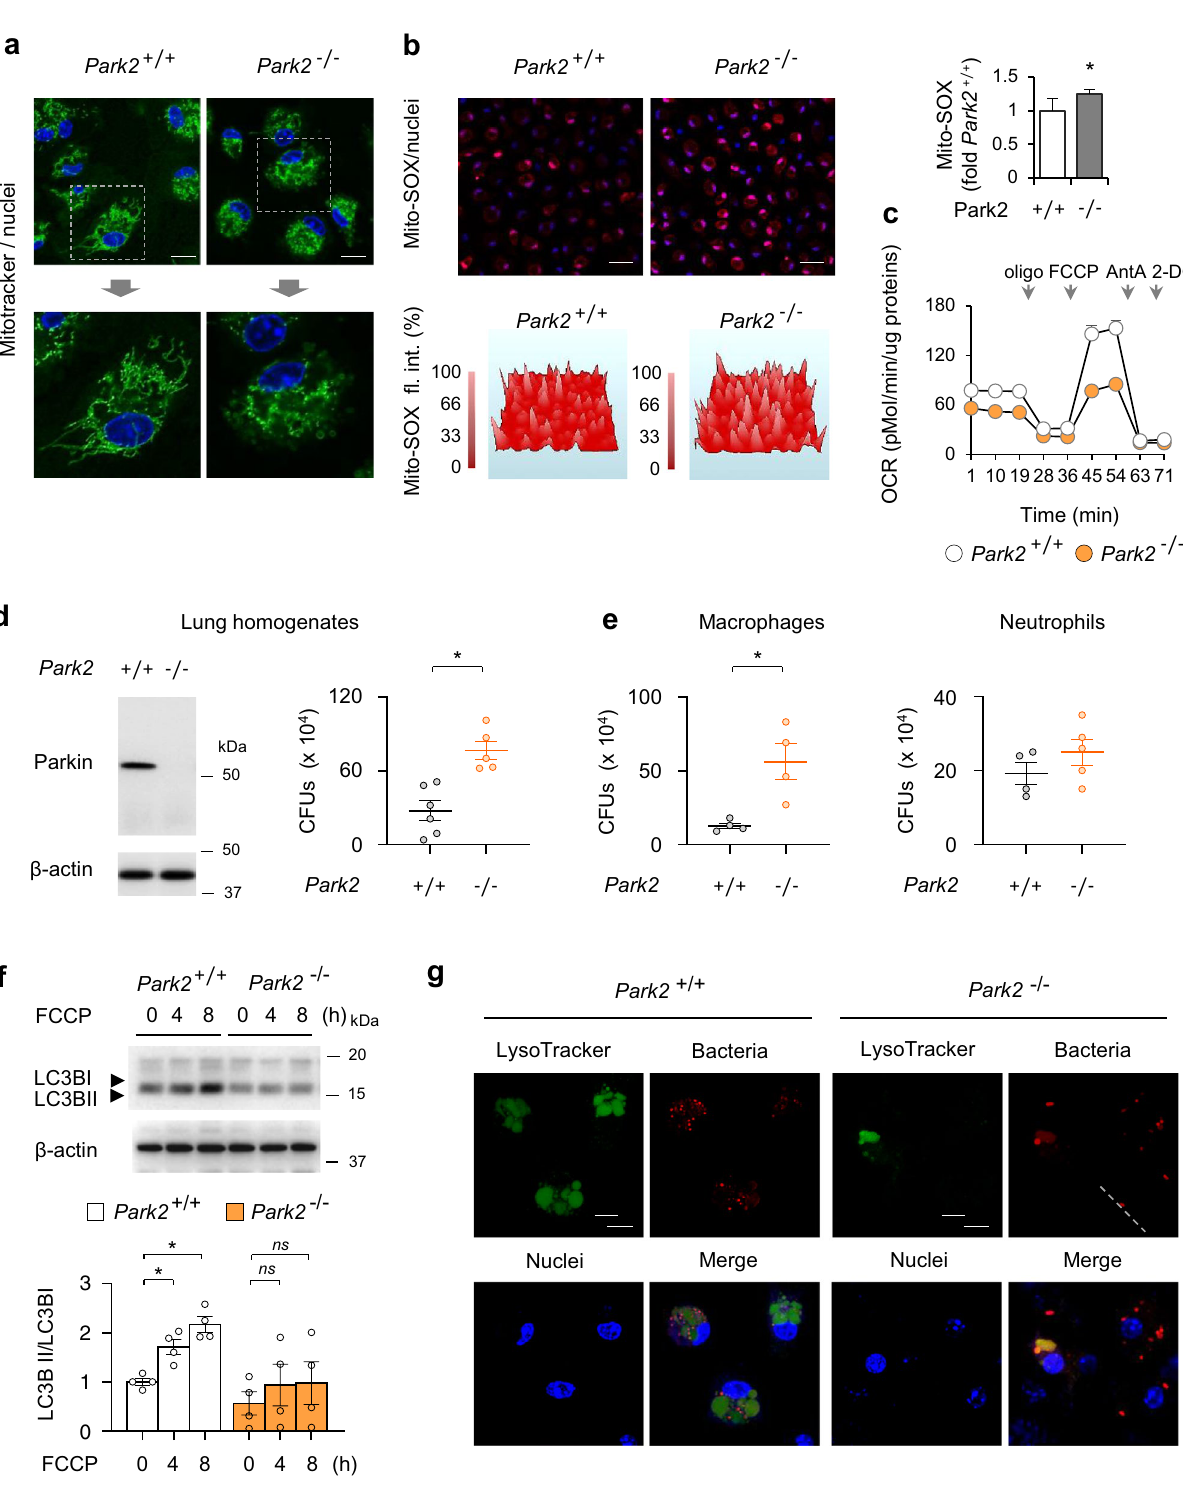
Figure 4. Parkin is required for phagolysosome formation and effective killing of bacteria. ( a ) Representative images show mitochondrial network in Park2 + / + and Park2 −/− macrophages. Mito-Tracker (green), nuclei (blue). Scale bar 10 µm. ( b ) Images, 3-D profiles, and Mito-SOX quantitation showing Mito-SOX fluorescence in Park2 + / + and Park2 −/− macrophages. Mito-SOX (red), nuclei (blue). Scale bar 50 µm. ( c ) Representative plot shows OCR indices (Mitochondrial Stress Test) in Park2 + / + and Park2 −/− macrophages. ( d ) Representative Western Blot ( left ) of Parkin in lungs of Park2 + / + and Park2 −/− mice. ( Right ) CFUs from lung homogenates of Park2 + / + and Park2 −/− mice that were subjected to bacteria ( i.t. ). Mean ± s.e.m., n = 5–6 mice per group. * P < 0.05, Student’s t -test. ( e ) CFUs after incubation of Park2 + / + and Park2 −/− macrophages or neutrophils with bacteria. Mean ± s.e.m., n = 4–5 individual measurements using cell populations obtained from 2 to 3 mice. * P < 0.05, Student’s t -test. ( f ) Western blot analysis of LC3BII/I in macrophages-treated with FCCP (0 or 500 nM) for indicated time. Mean ± s.e.m., n = 4. * P < 0.05, ANOVA. ( g ) Images depicted phagolysosome formation in Park2 +/+ and Park2 −/− macrophages incubated with bacteria (red). LysoTracker (green), nuclei (blue). Scale bar 10